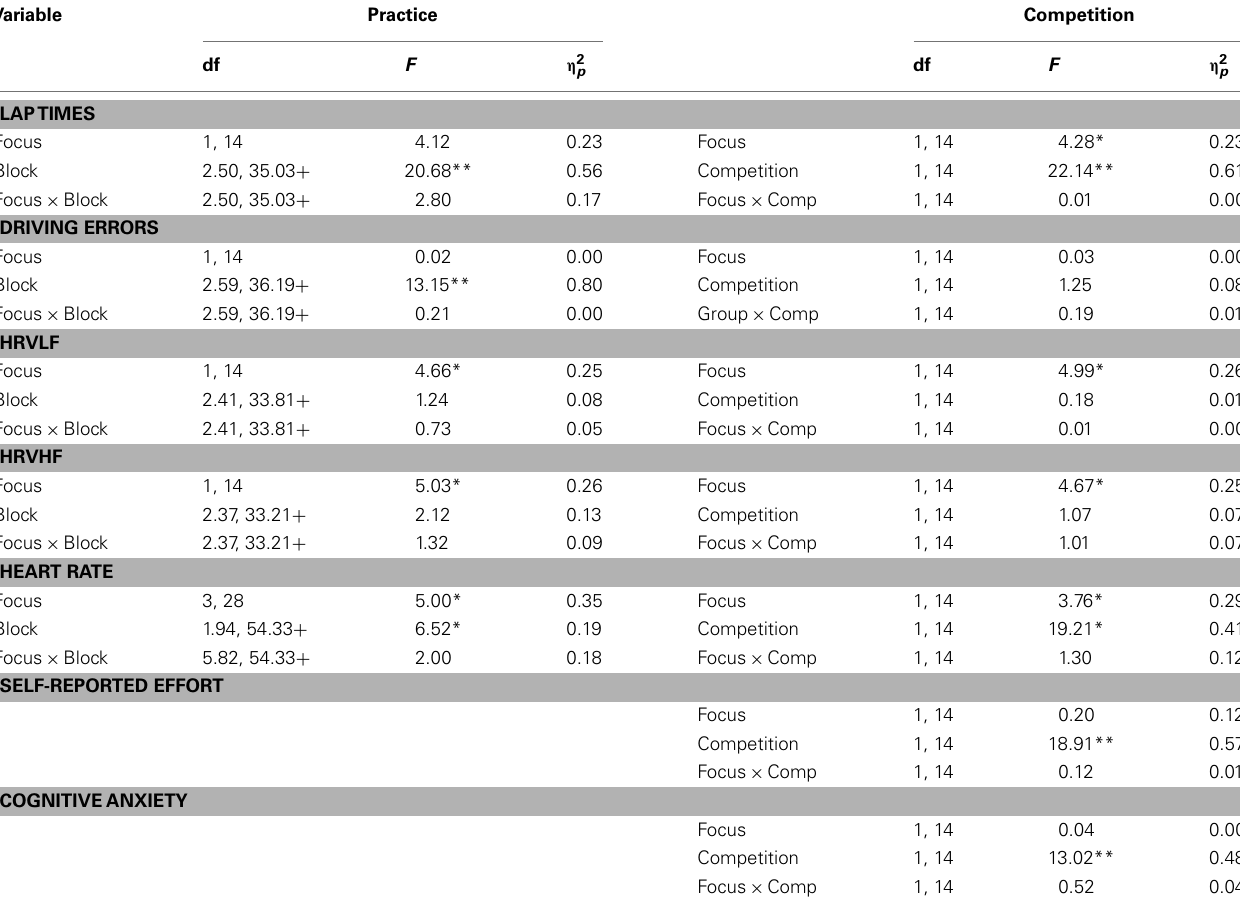
Table 2 |ANOVA summaries for all variables for practice and